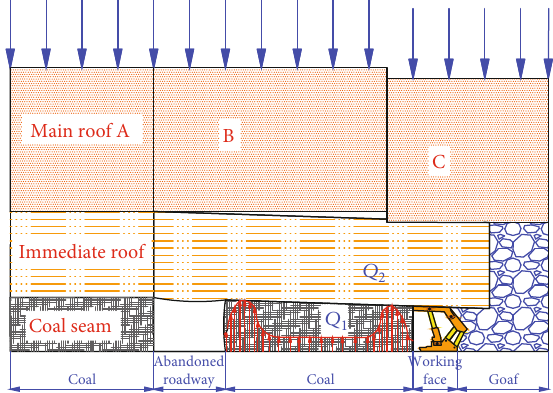
Figure 4: Schematic diagram of crossing the abandoned roadway during initial